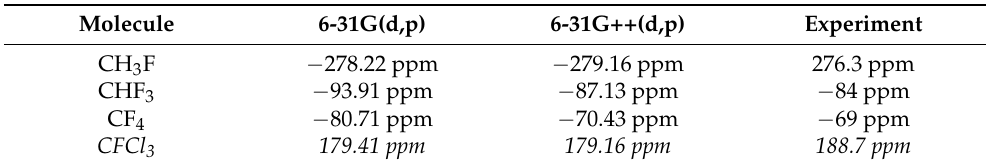
Table 1. An example of the GIAO-DFT calculated 19 F chemical shifts for fluoromethanes; the selected data are cited from Ref.